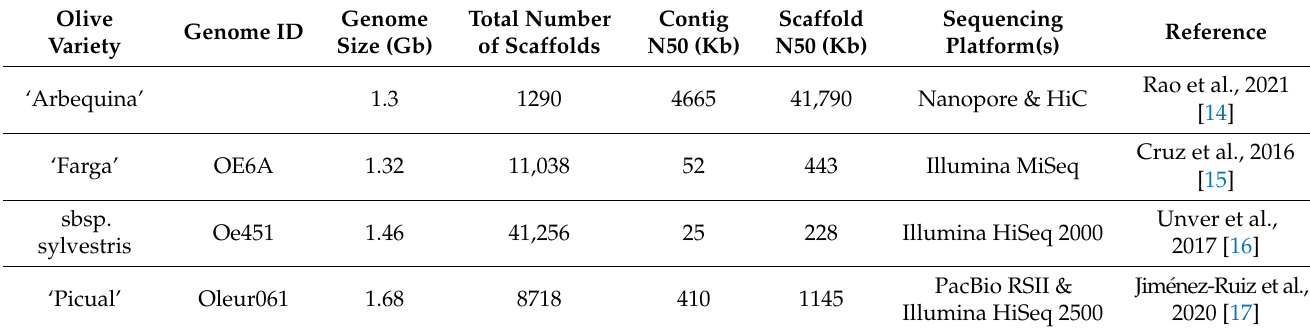
Table 1. Publicly available assemblies of olive